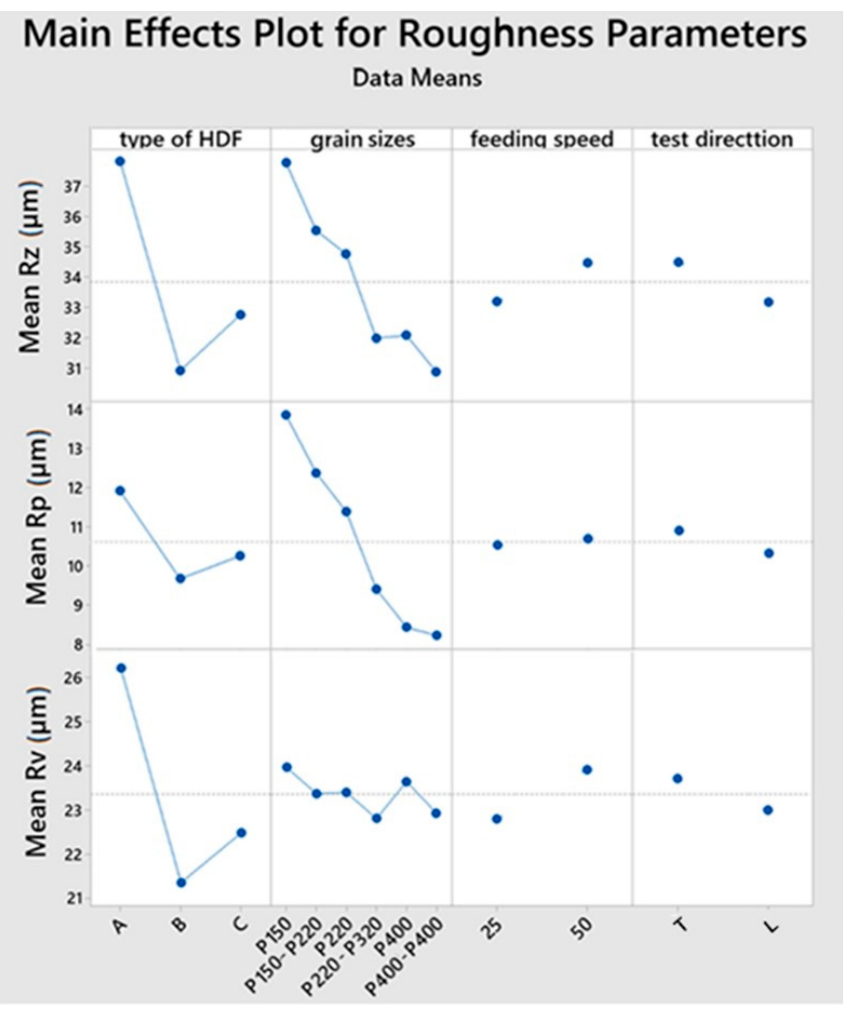
Figure 3. Main effects plots for mean of height roughness parameters (the maximum peak height of the roughness profile Rp, the maximum valley depth of the roughness profile Rv, ten-point height Rz) for four factors.